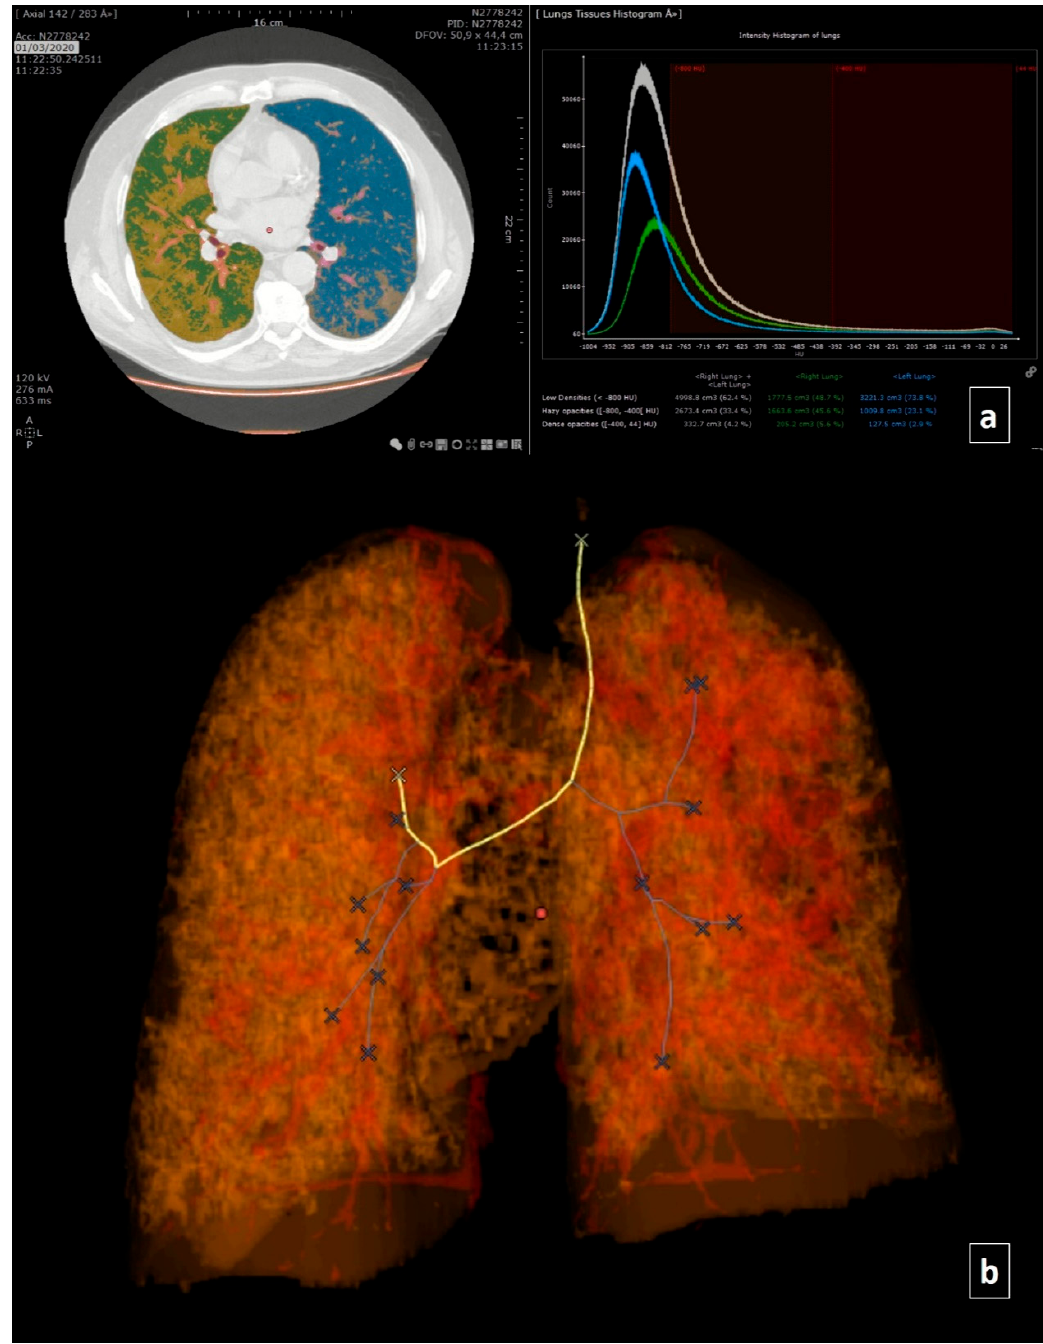
Figure 2. The same case of Figure 1. Automatic Segmentation of Thoracic Disease by COVID-19 using the Myriam Tool of Intrasense: ( a ) Intensity histogram of lungs; ( b ) 3D reconstruction.